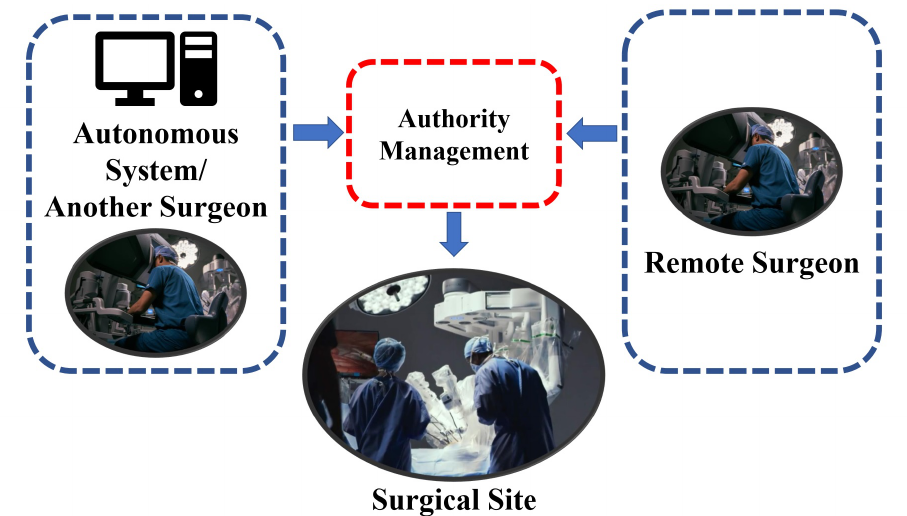
Figure 9. Shared control based on authority management, in the specific case of a dual-user topology (Images ©2020 Intuitive Surgical,